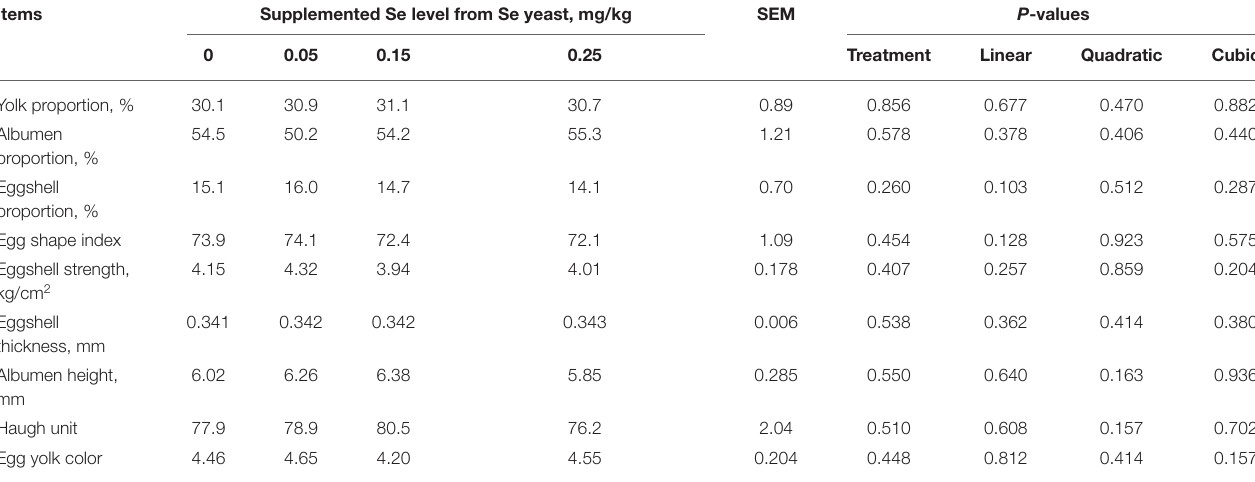
TABLE 3 | Effect of dietary Se yeast supplementation on the egg quality of Longyan laying ducks ( n = 6) a . Items Supplemented Se level from Se yeast, mg/kg